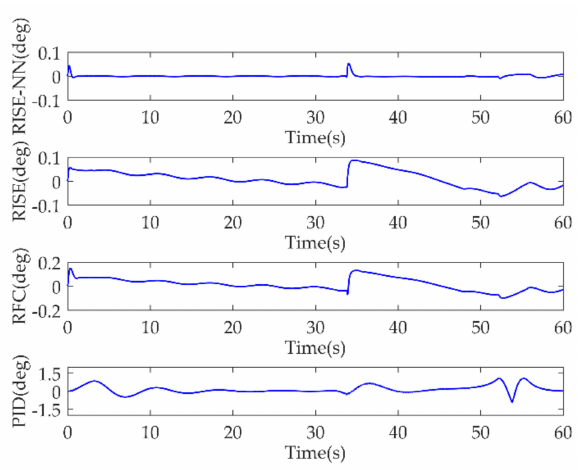
Figure 11. Tracking errors of the four controllers in case 1.